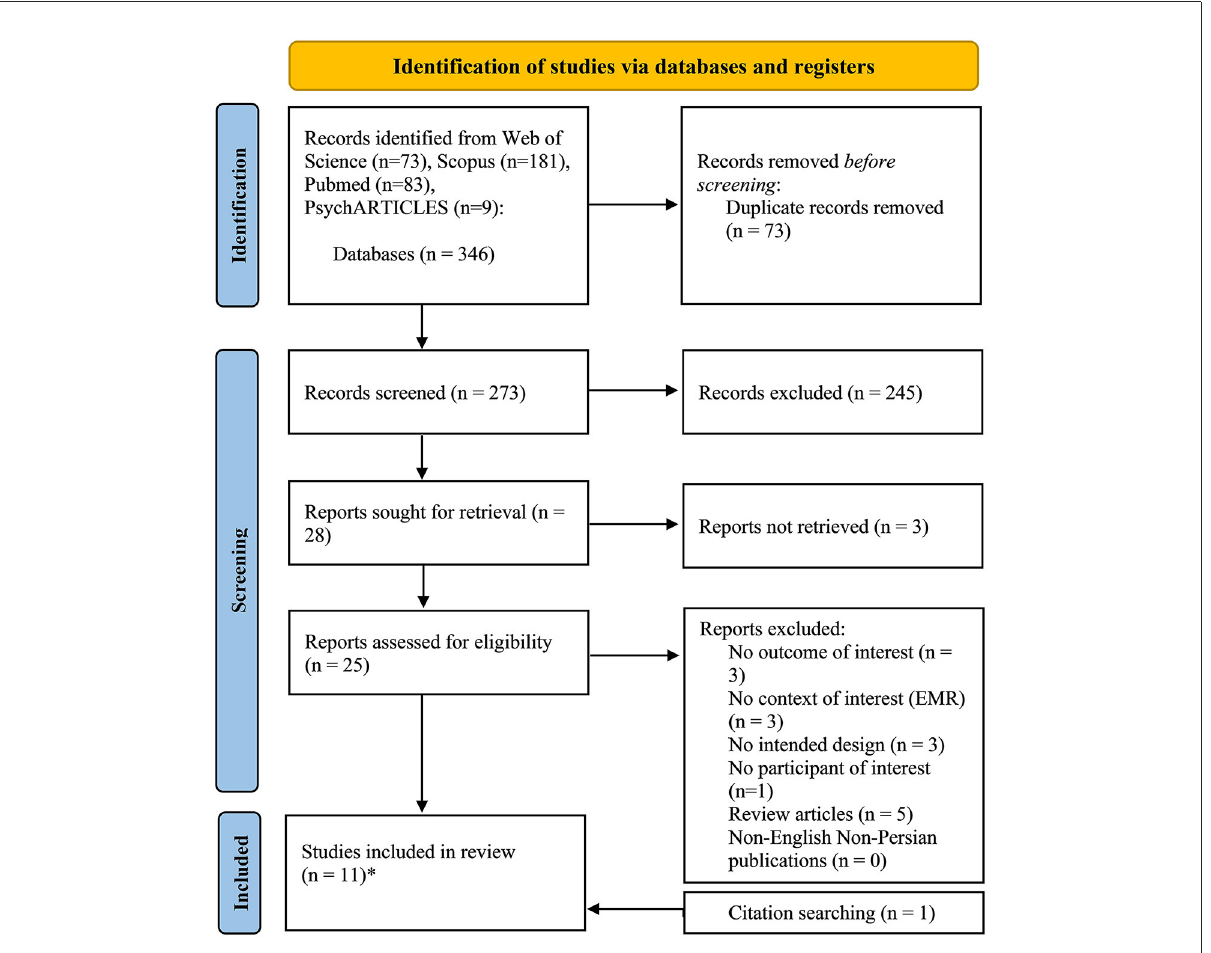
FIGURE1 The PRISMA diagram presenting the procedure of literature searching and selection with numbers of articles at each stage. *One of these studies was not included in the final discussion due to the risk of bias regarding our review question.